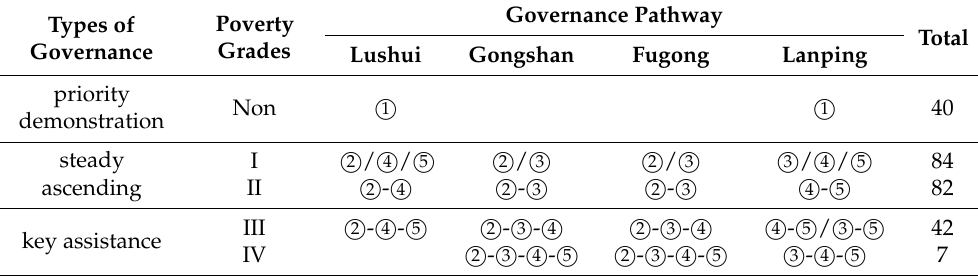
Table 6. Relative poverty governance